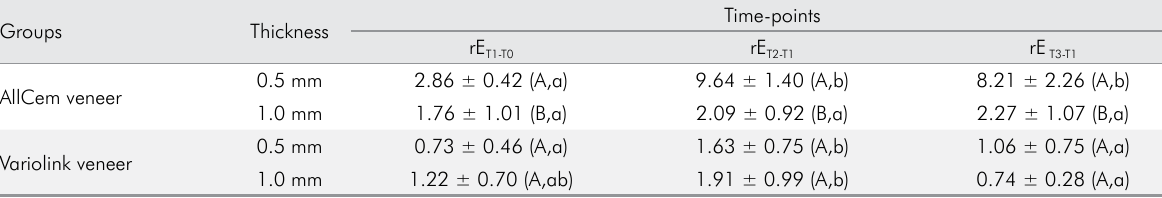
) color measurement observed in each experimental set (mean ± STD). 00